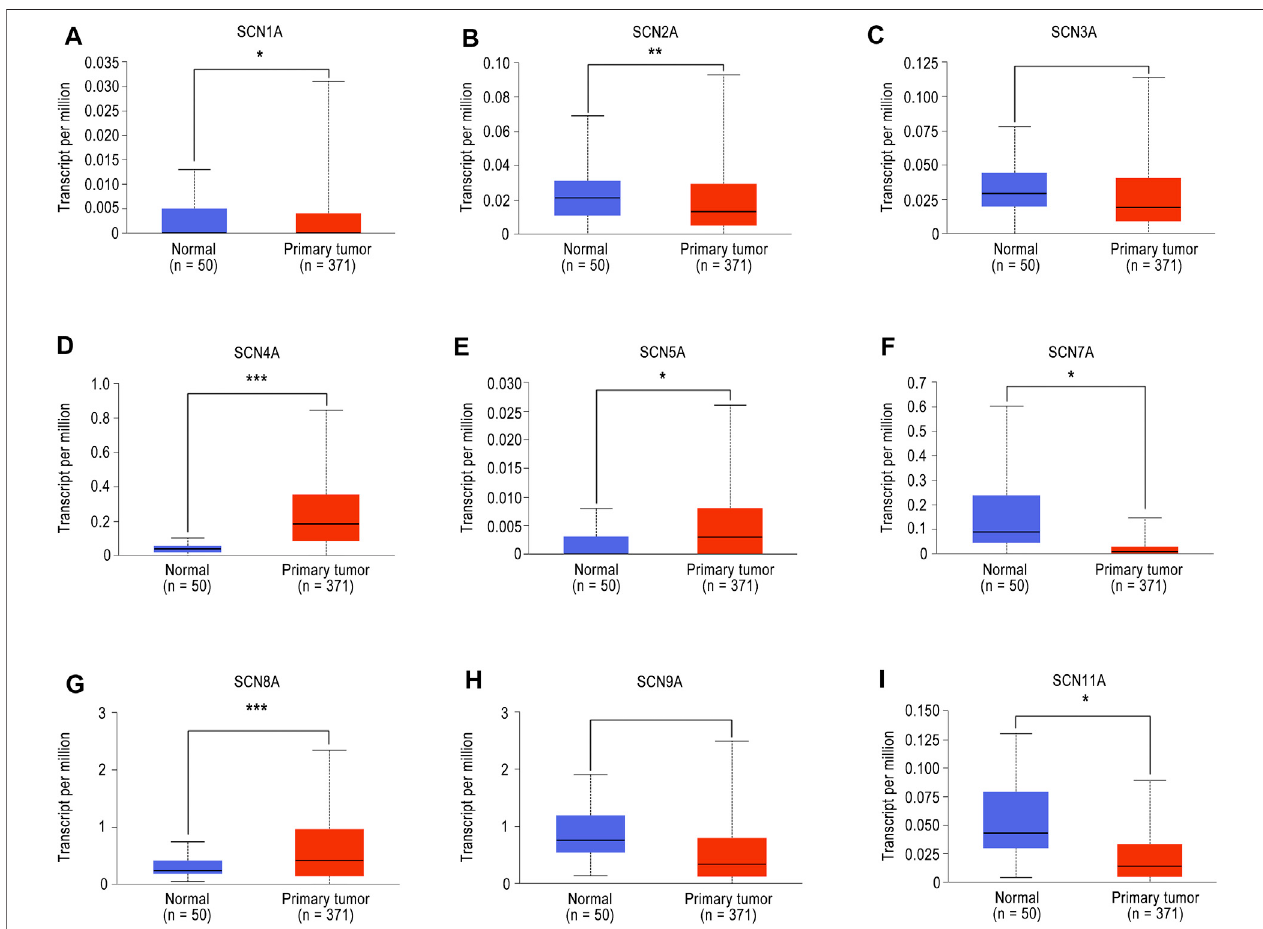
FIGURE 1 | The mRNA expression of SCN family member in UALCAN. (A) SCN1A mRNA expression in tumour tissues and normal tissues. (B) SCN2A mRNA expression in tumour tissues and normal tissues. (C) SCN3A mRNA expression in tumour tissues and normal tissues. (D) SCN4A mRNA expression in tumour tissues and normaltissues. (E) SCN5A mRNAexpressionintumourtissuesandnormaltissues. (F) SCN7A mRNAexpressionintumourtissuesandnormaltissues. (G) SCN8A mRNA expression in tumour tissues and normal tissues. (H) SCN9A mRNA expression in tumour tissues and normal tissues. (I) SCN11A mRNA expression in tumour tissues and normal tissues. * p < 0.05, ** p < 0.01, *** p <